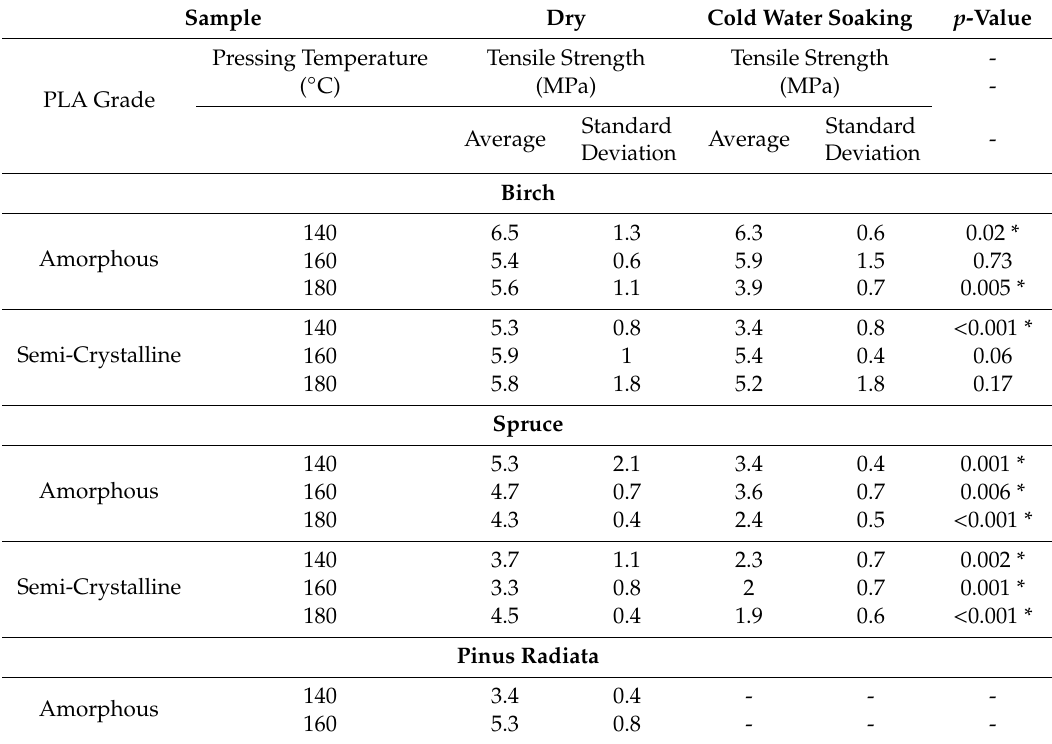
Table 4. Summary of tensile testing results for inner bondlines of laminated panels, tested dry and tested after 24 h of cold water